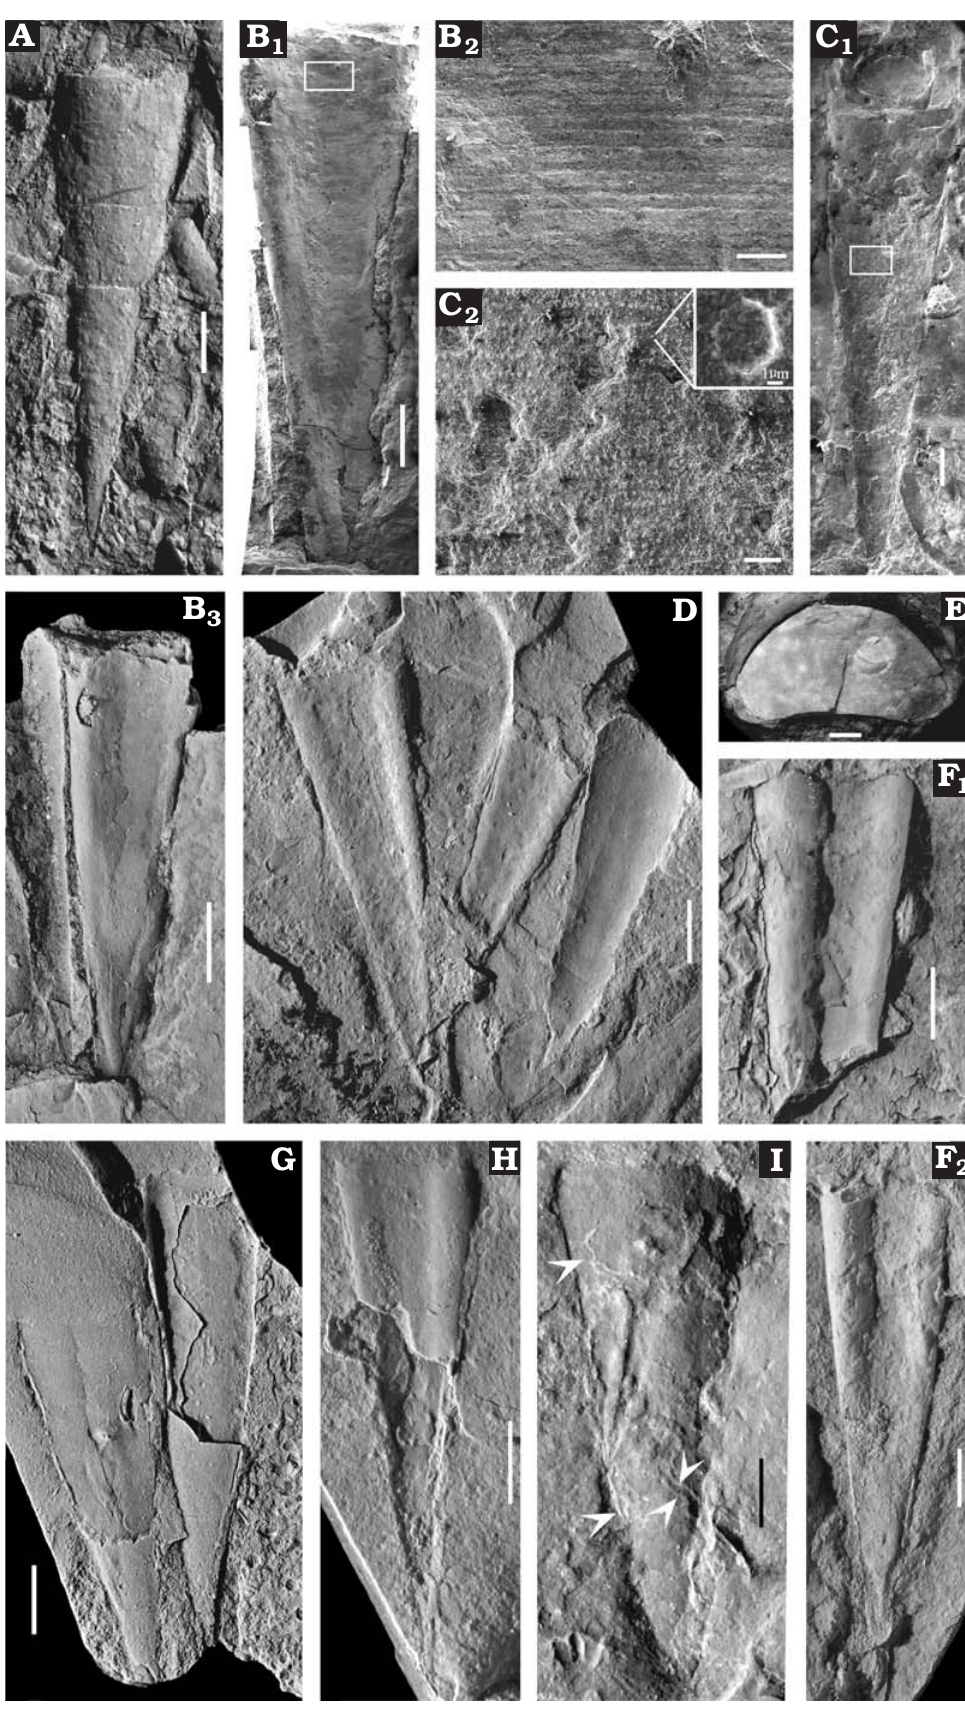
Fig. 3. Novitatid hyolith Decoritheca cyrene (Walcott, 1905) from the Manto Formation (Cambrian Stage 4/5) in the Zuojiawu section of Tang- shan, China. A . NIGPAS 166338 in dorsal view. B . NIGPAS 166335 in ventral (B 1 ) and ventro-lateral (B 3 ) views; detail showing transverse lines on the external surface of venter (B 2 ). C . NIGPAS 166337 in dorsal view, conch of Decoritheca cyrene with operculum of Cupitheca convexa sp. nov. in apertural region (C 1 ); rows of tubercles (C 2 ), inset shows enlarged individual tubercle with nearly flat top. D . NIGPAS 166329 in ventral view. E . NIGPAS 166341b, aperture with reniform cross section. F . NIGPAS 166331 in ventral view; F 1 , incomplete shell showing well developed median concavity and adjacent rid ges; F 2 , nearly complete shell with broken aperture and adapically shallow- ing median concavity. G . NIGPAS 166330, both shells dis play partial venter and partial dorsum from dorsal view. H . NIGPAS 166333 in ventral view. I . NIGPAS 166332 in dorsal view, white arrows indicate algae. Scale bars: A, D, B 3 , F–I, 2 mm; B 1 , C 1 , 1 mm; B 2 , 100 μ m; C 2 , 20 μ m; E, 200 μ